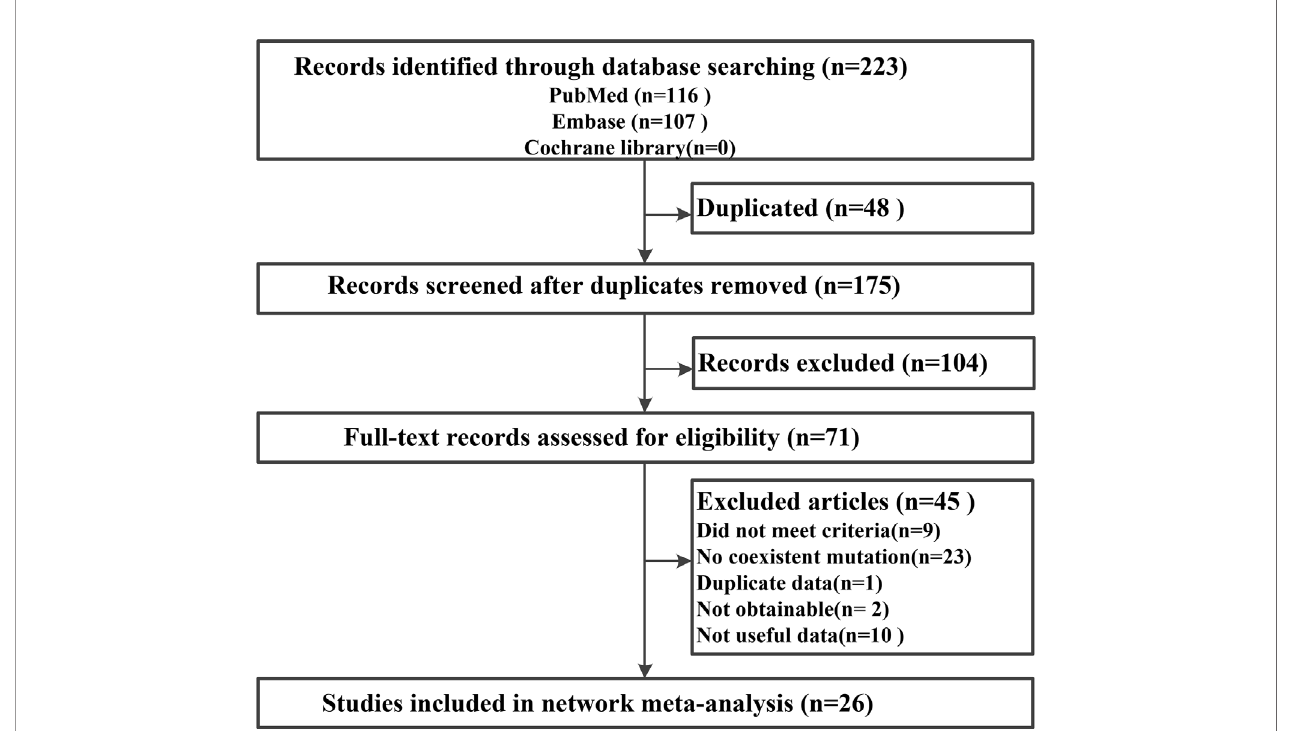
FIGURE 1 | A fl owchart summarizing all study assessment